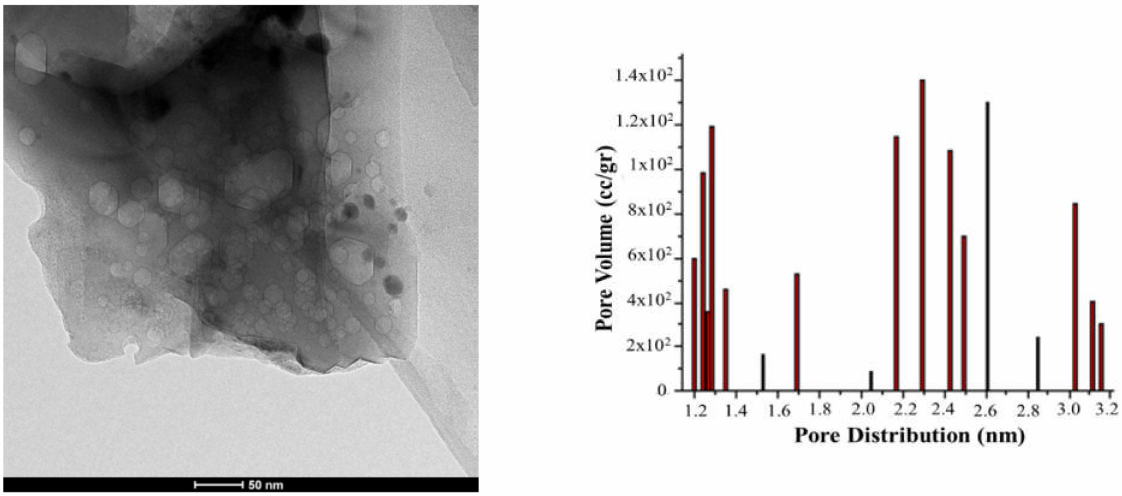
Figure 8. Greater absorption as the temperature rises and TEM Activated Carbon at 700 ◦ C and its pore distribution. Adapted with permission from Ref. [113].